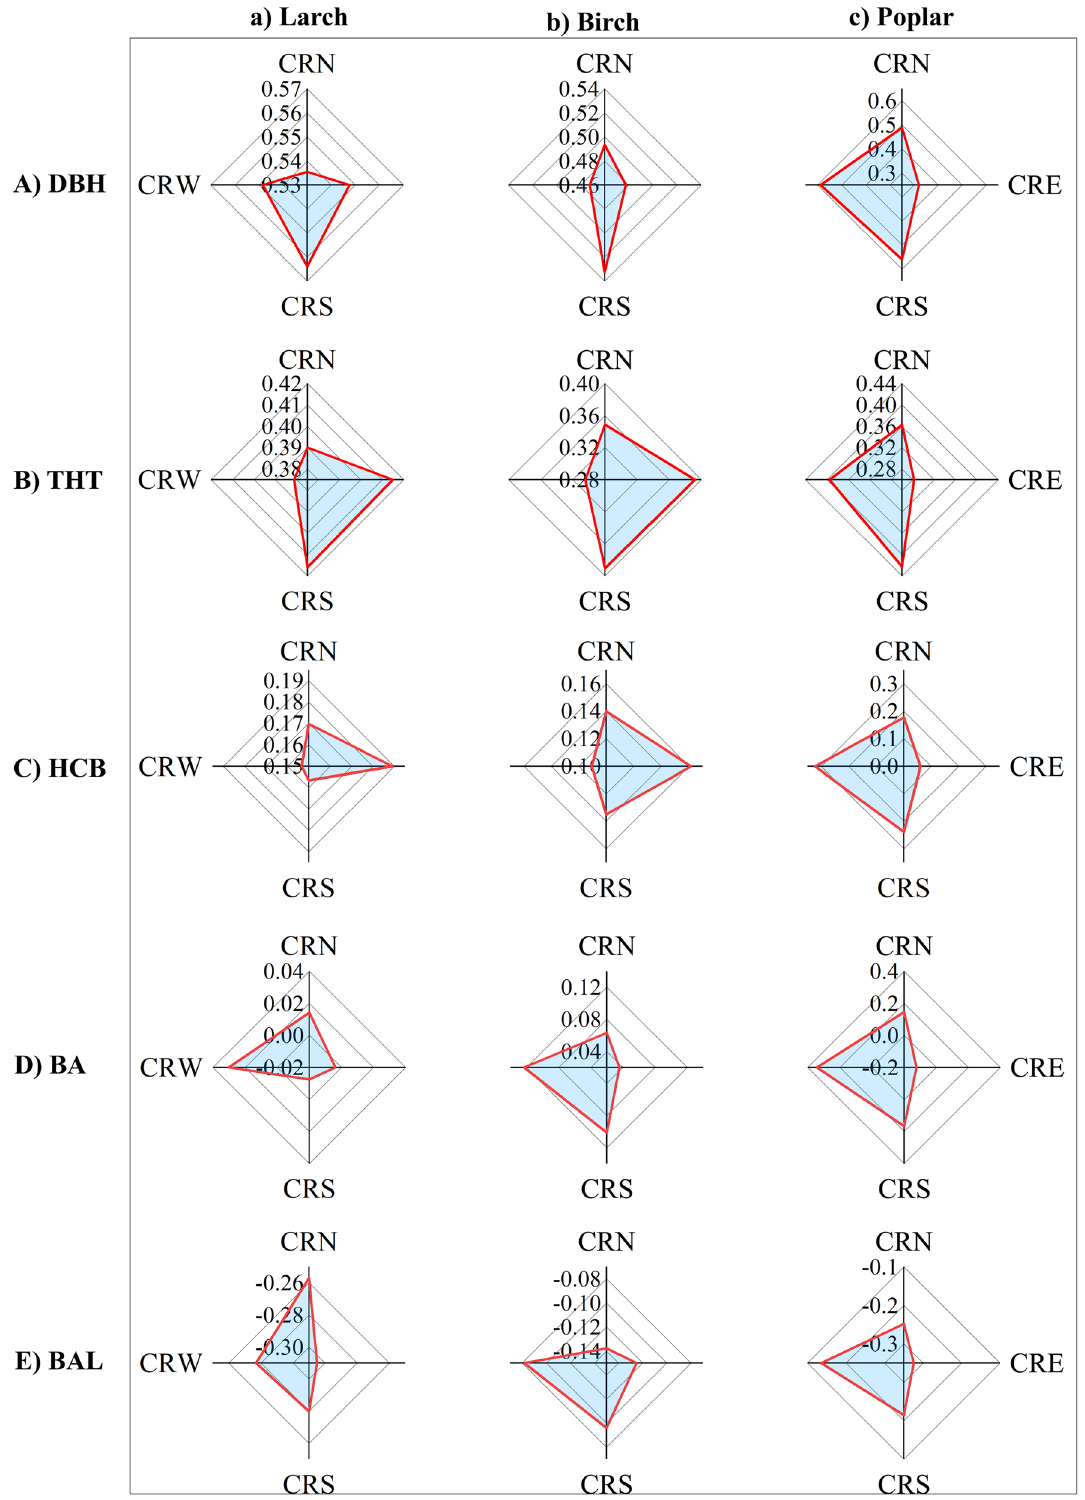
Fig. 3 Radar plots of Pearson correlation coefficients between CR and A DBH, B THT, C HCB, D BA, and E BAL for a) larch, b) birch, and c)